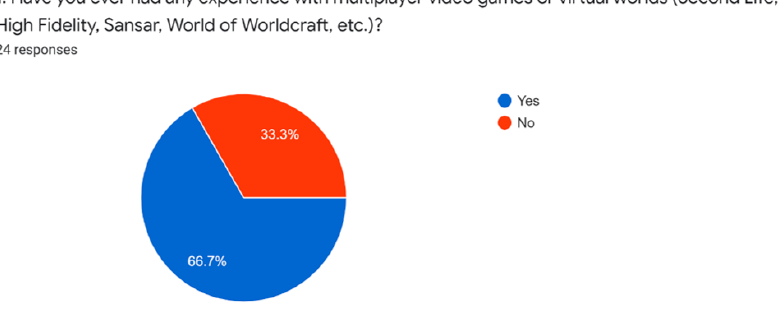
Figure 9. VoRtex test results from Google Forms report. Participant background.